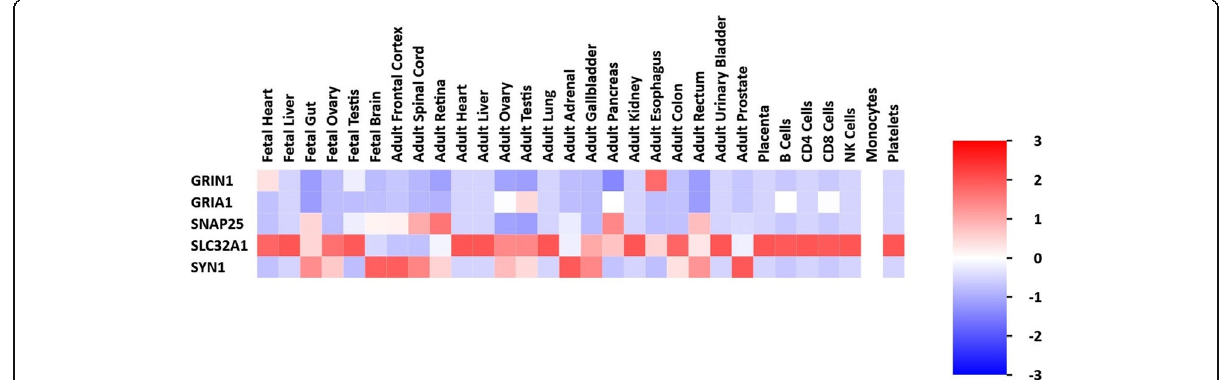
Fig. 6 Heatmap of hub genes constructed using the FunRich